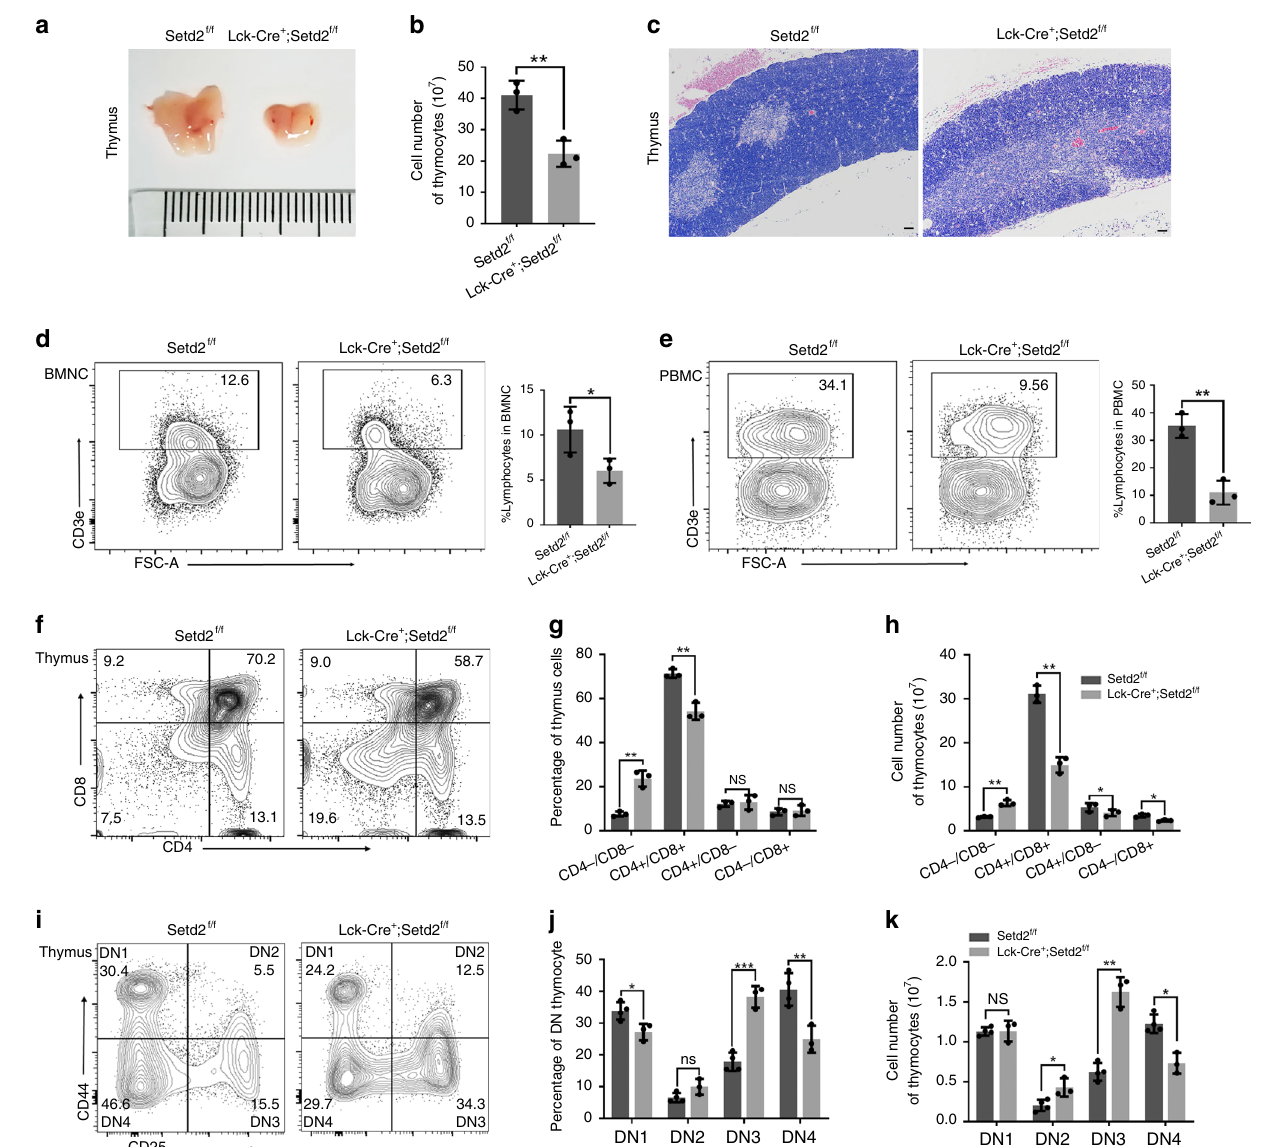
Fig. 4 Lymphoid-speci fi c deletion of Setd2 leads to a block of T cell development at the DN3 stage. a Lck-Cre + ;Setd2 f/f mice exhibit a visibly smaller thymus than control mice (unit of ruler = 1 mm). b The thymocyte cell number was signi fi cantly lower in Lck-Cre + ;Setd2 f/f mice than in control mice ( n = 6). c Representative hematoxylin – eosin (H&E)-stained thymus sections from Lck-Cre;Setd2 fl / fl and control mice (scale bar = 50 μ m). d , e Flow cytometric analysis of CD3e + T cell populations in bone marrow mononuclear cells (BMNCs) ( d ) and peripheral blood mononuclear cells (PBMCs) ( e ) indicated a reduced CD3e + T cell population in Lck-Cre + ;Setd2 f/f mice ( n = 6). f – h Flow cytometric analysis of subpopulations of double negative T cells in Lck-Cre + ; Setd2 f/f mice and control mice with CD4 and CD8 staining ( n = 6). i – k Flow cytometric analysis indicated that the subpopulations of DN2 (CD44 − CD25 + ) and DN3 (CD44 − CD25 + ) thymocytes were signi fi cantly increased, whereas the DN4 (CD44 − CD25 − ) thymocyte population was reduced, in Lck-Cre + ; Setd2 f/f mice ( n = 6). (The data are presented as the means ± SDs. * p < 0.05; ** p < 0.01; *** p < 0.001; ns, not signi fi cant, Source data are provided as